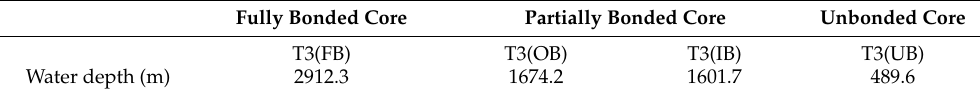
Table 6. Installation depth of various SPs in regard to target reliability.